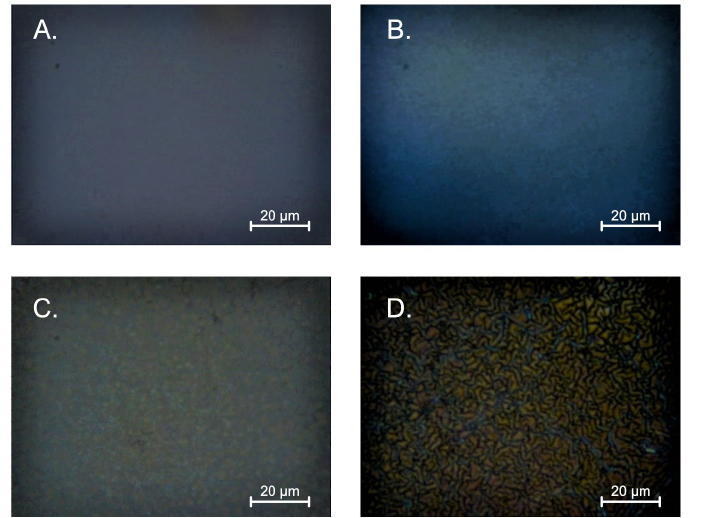
Figure 3. Summary of the morphology for the layers produced on sapphire ( A ) using a solution with 5% concentration of DEA; ( B ) using a solution with 10% concentration of DEA; ( C ) using a solution with 5% concentration of MEA; ( D ) using a solution with 10% concentration of MEA.